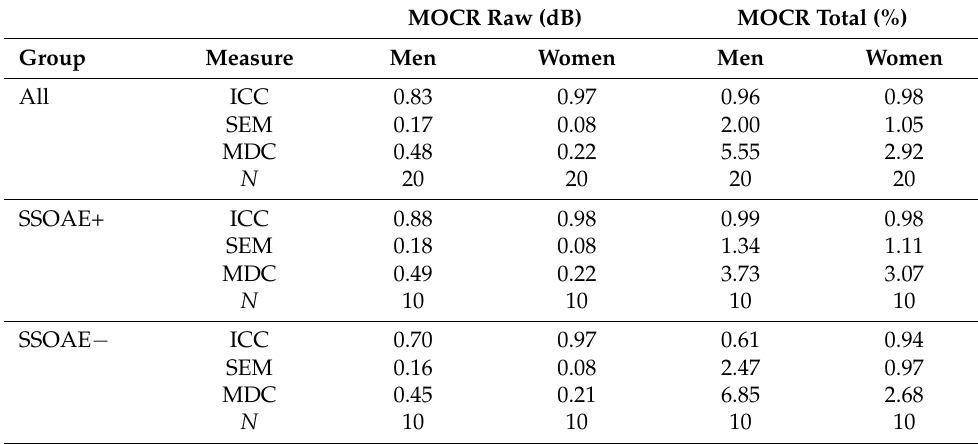
Table 3. ICC, SEM, and MDC of MOCR for raw effect (in dB) and total effect (in %). The data are divided according to SSOAE presence. Key: ICC, intraclass correlation coefficient; SEM, standard error of measurement; MDC, minimum detectable change for 95% interval; N , number of subjects/ears in each subgroup; SSOAE+, ears with SSOAEs; SSOAE − , ears without